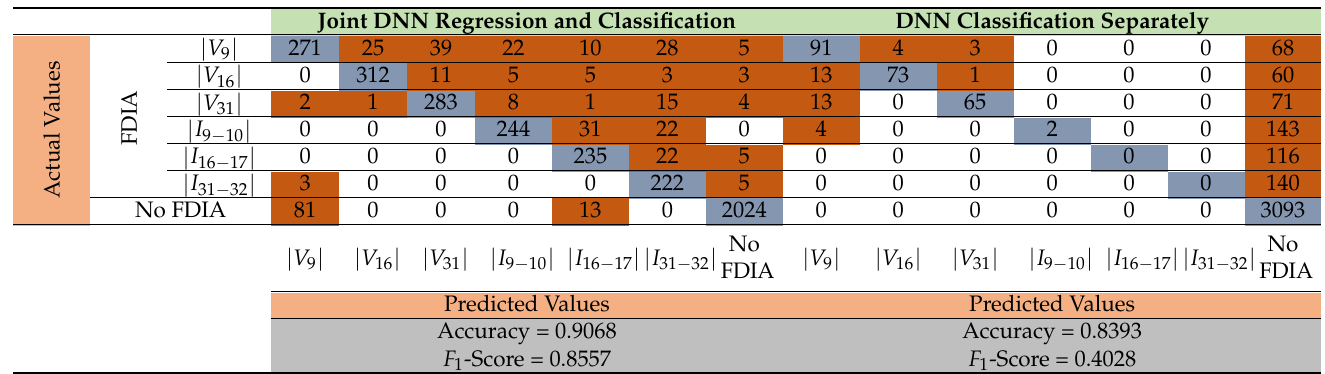
Table 3. Confusion Matrix Showing Bad Data Detection Results and Accuracy Values Obtained Using the Proposed Method and the Binary Classification-only DNN Model when N a = 1200 ( 10% ) , z a = ∼ N ( µ z , σ z ) .